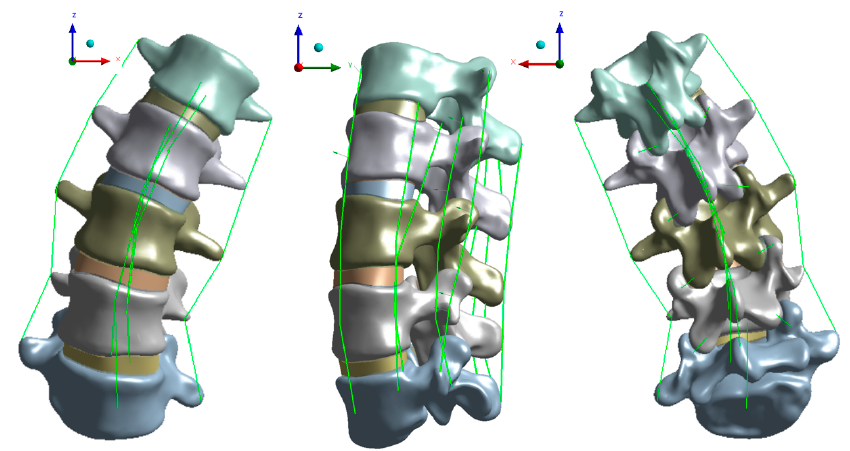
Figure 1. 3D model and ligament of scoliosis lumbar vertebra.